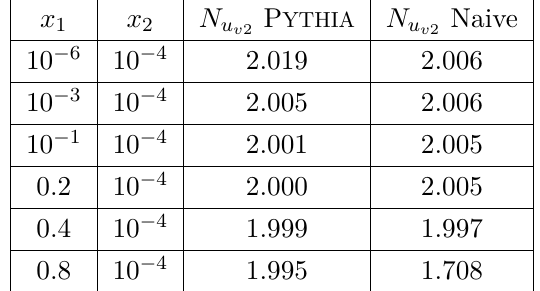
Table 10 . Integration over R u ¯ uu response function with respect to x 3 at fixed x 1 , x 2 . In the ideal situation when the GS sum rules are perfectly satisfied N u